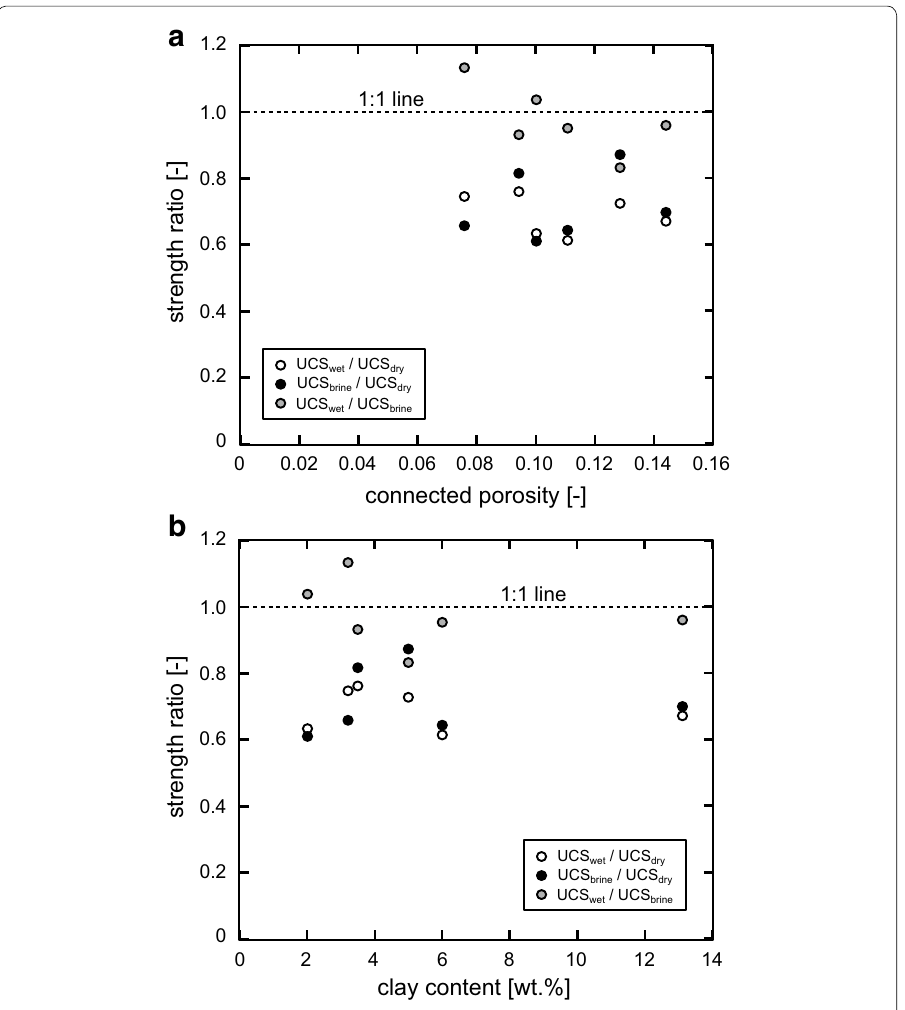
Fig. 7 a Ratios of water-saturated-to-dry uniaxial compressive strength, brine-saturated-to-dry uniaxial compressive strength, and water-saturated-to-brine-saturated uniaxial compressive strength for the six sandstones sampled from exploration well EPS-1 at Soultz-sous-Forêts (France) as a function of connected porosity. b Ratios of water-saturated-to-dry uniaxial compressive strength, brine-saturated-to-dry uniaxial compressive strength, and water-saturated-to-brine-saturated uniaxial compressive strength for the six sandstones sampled from exploration well EPS-1 at Soultz-sous-Forêts as a function of clay content (clay content is the wt% of muscovite/illite–smectite; Table